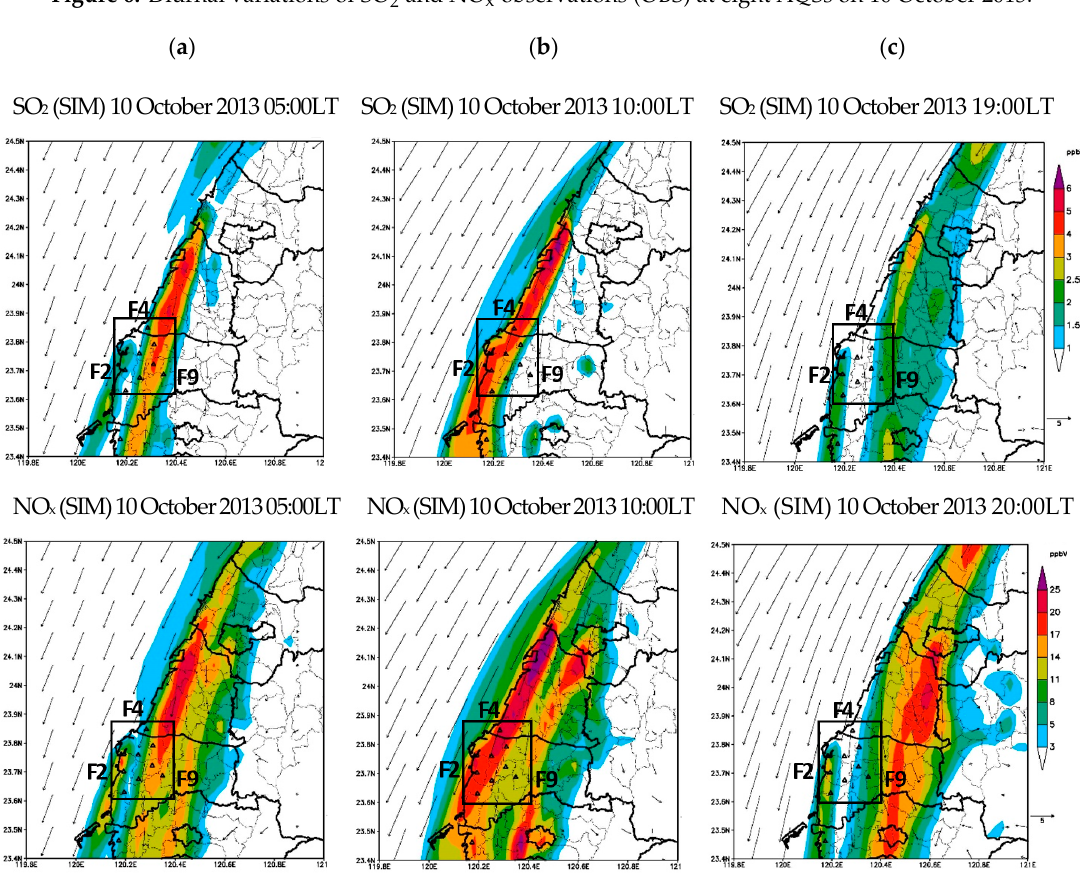
Figure 7. Progression of surface wind field (m / s), SO 2 , and NO x (ppbv) at local times (LT) of 5:00 ( a ), 10:00 ( b ), 20:00 ( c ) from simulations (SIM) under a typical NEM condition. Black box represents the Petro–region and small triangles represent the nine AQSs.